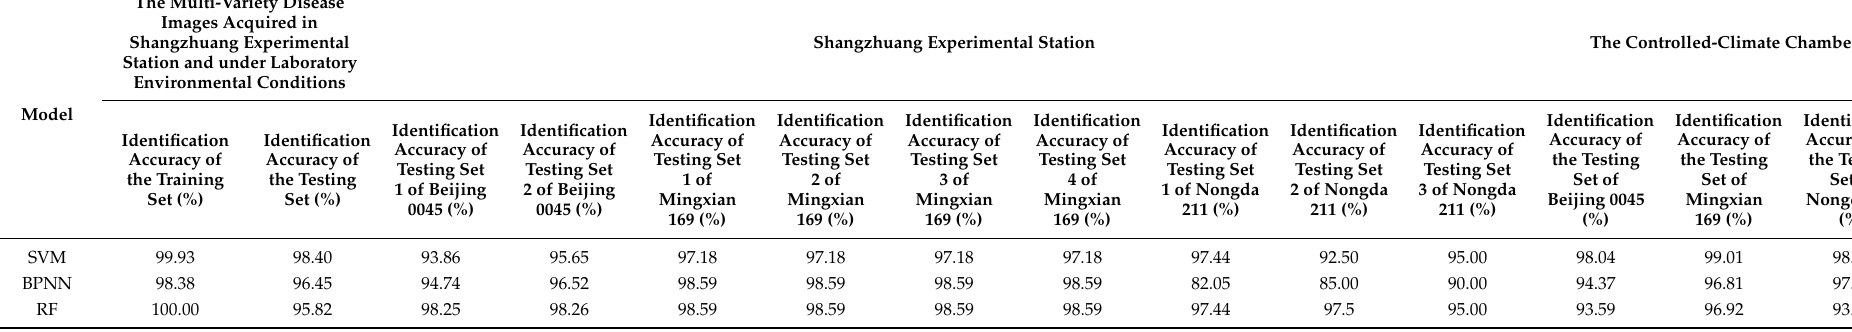
Table 17. Identification results for the multi-variety disease image testing set consisting of disease images acquired in the wheat field in Shangzhuang Experimental Station and under laboratory environmental conditions, the individual-variety disease image testing sets acquired in the wheat field in Shangzhuang Experimental Station and under laboratory environmental conditions, and the additional testing set consisting of the multi-variety disease images acquired in the wheat field in Gangu Testing Station using the SVM, BPNN, and RF models built based on the multi-variety disease image training set consisting of disease images acquired in the wheat field in Shangzhuang Experimental Station and under laboratory environmental